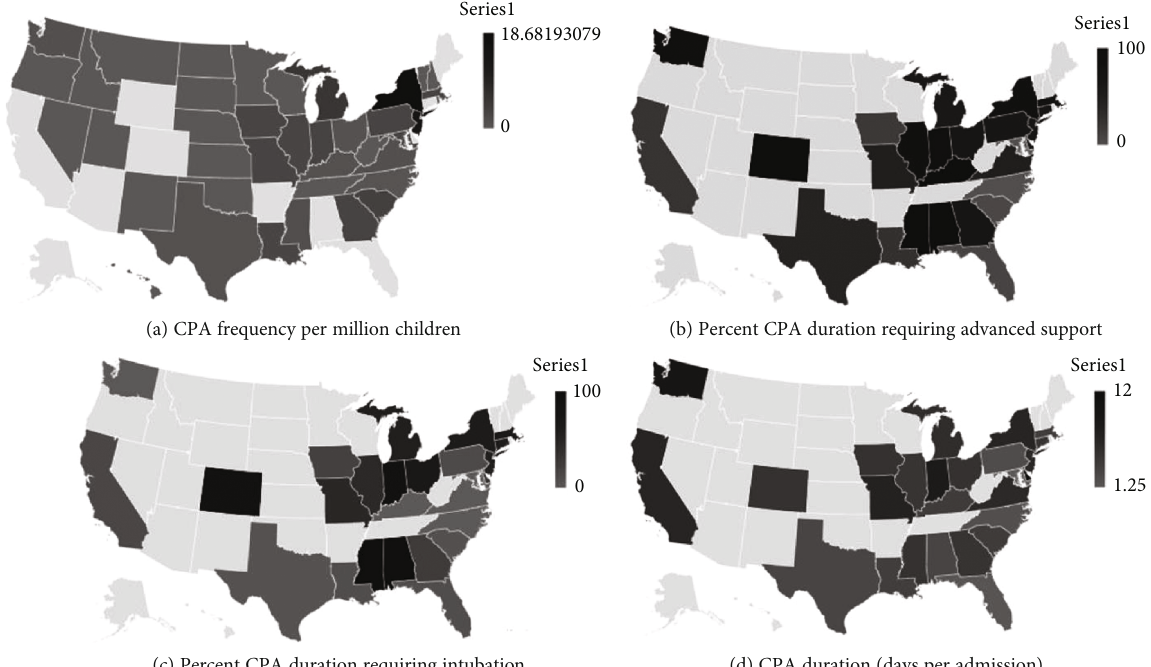
Figure 1: COVID-19 pediatric intensive care unit admission characteristics by state. (a) COVID-19 pediatric admission frequency per million children. (b) Percent of COVID-19 pediatric admission duration requiring advanced respiratory support. (c) Percent of